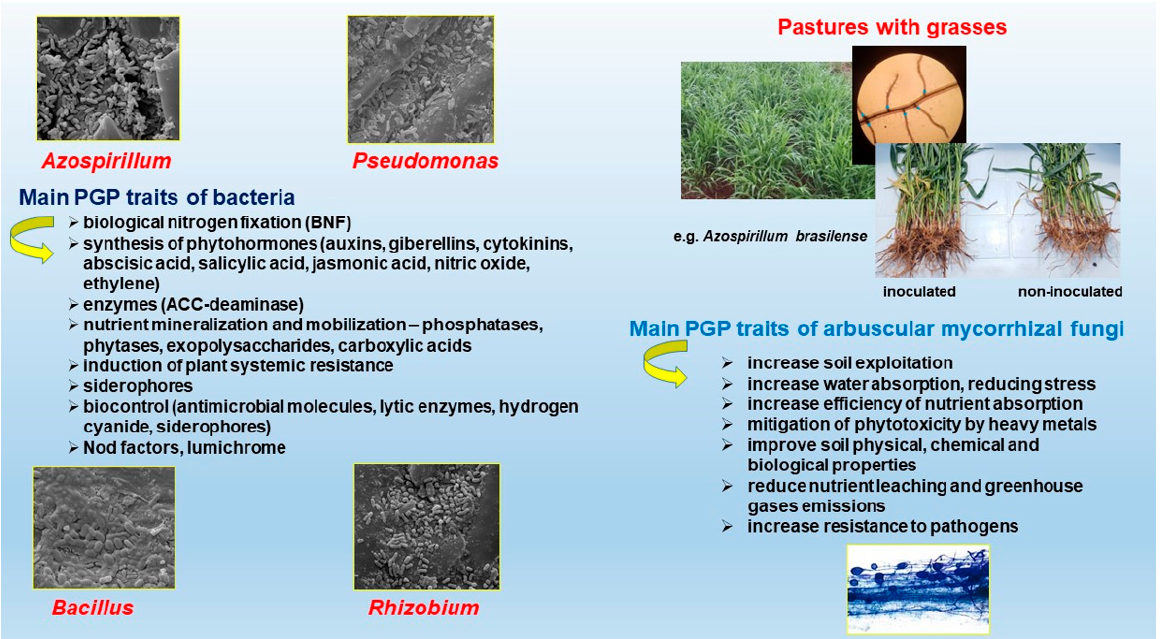
Figure 1. Main plant-growth-promoting (PGP) traits associated with the main bacteria used in studies or in commercial products for pastures with grasses, Azospirillum , Pseudomonas , Bacillus, Rhizobium , and arbuscular mycorrhizal fungi.